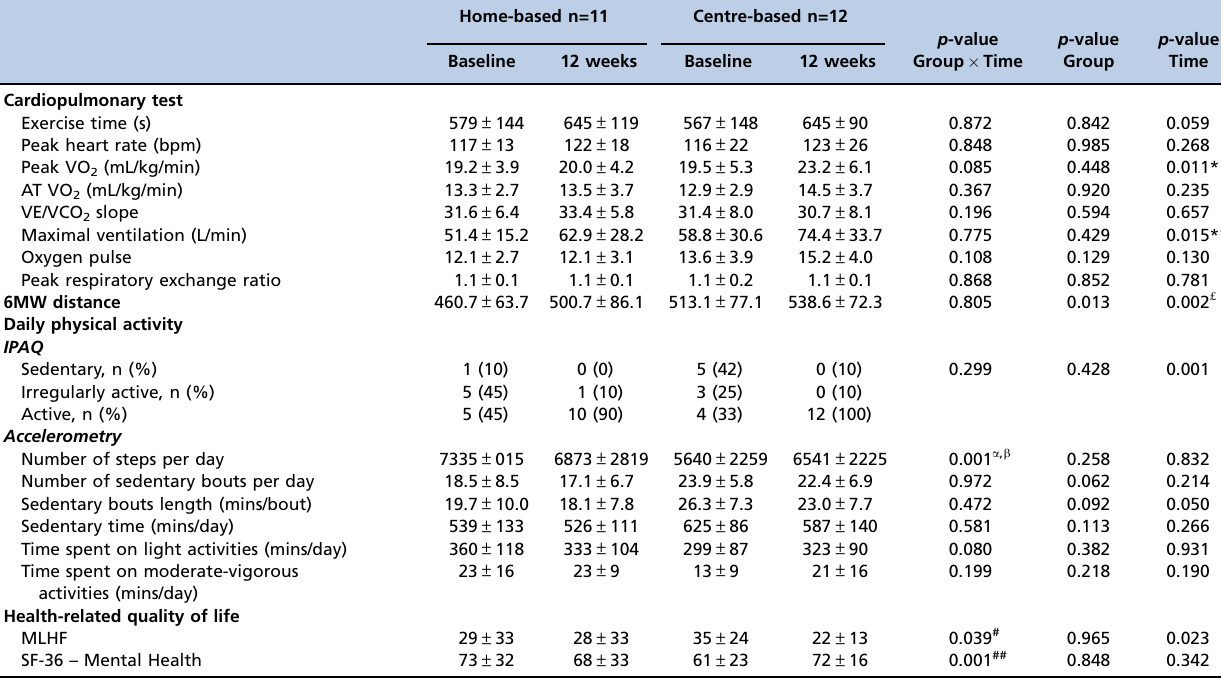
Table 2 - Functional capacity, physical activity level, and quality of life (mean values ± SD) at baseline and after 12 weeks in both groups using a mixed linear model and physical activity level assessed by the IPAQ, using a non-parametric two-way analysis of variance for repeated measures.